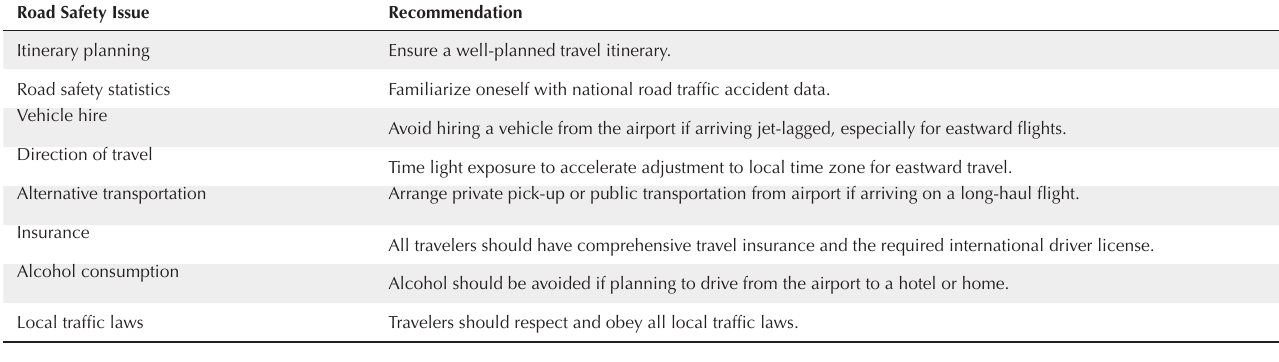
Table 1. Recommendations for the Prevention of Jet Lag-Related Road Traffic